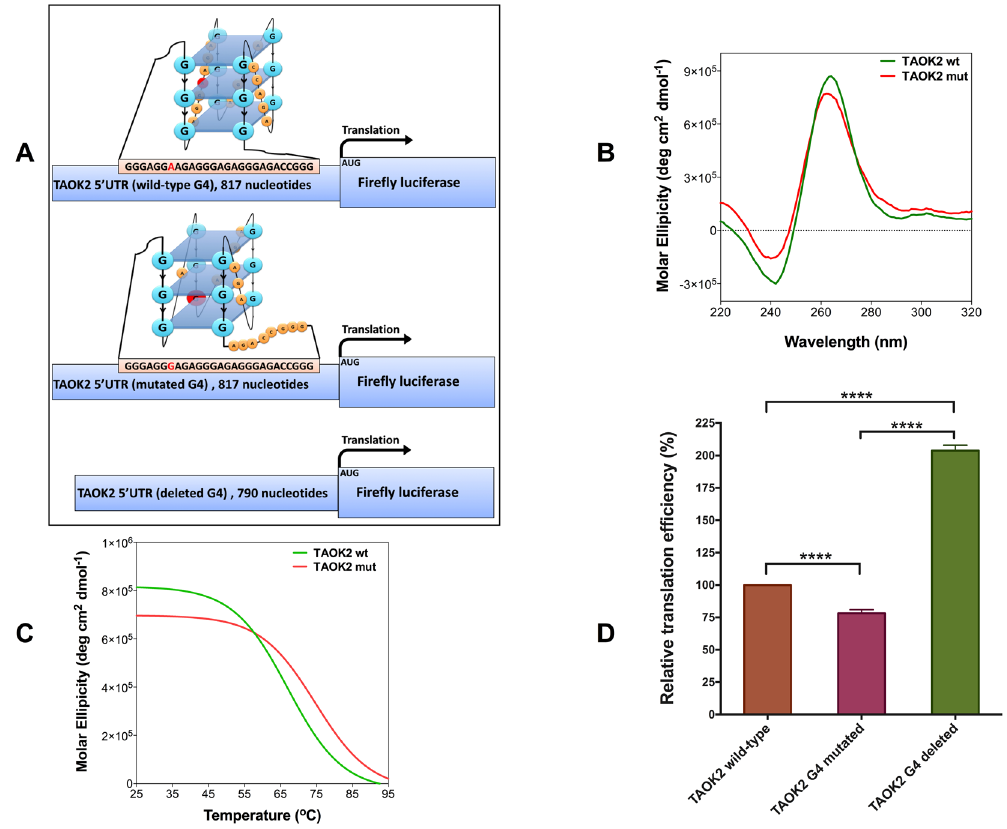
Figure 6. A point mutation in the 5 ′ UTR of TAOK2 stabilises the RNA G4 and affect its regulatory function. ( A ) Schematic representation of three different mRNAs of firefly luciferase reporter constructs. Wild-type construct contains full-length 5 ′ UTR of TAOK2 . In the G4-mutated construct, an adenine is replaced by a guanine. To make the G4-deleted construct, 27 nucleotides that predicted to form the G4 were deleted. Schematic drawing of wild-type and mutated G4s are proposed based on RNAfold and QGRS-mapper predictions and in vitro results. ( B ) CD spectra of TAOK2 wild-type and mutated RNA G4 oligos in KCl. ( C ) CD melting curves of TAOK2 wild-type and mutated RNA G4 oligos at 260 nm. ( D ) Relative in vitro translation efficiency of the wild-type, G4-mutated and G4-deleted constructs as judged by measuring firefly luciferase enzymatic activity. Data were analysed using one-way-ANOVA (n ≥ 3, error bars represent the SEM, asterisks ( * ) indicate significance calculated by the Tukey multiple comparisons